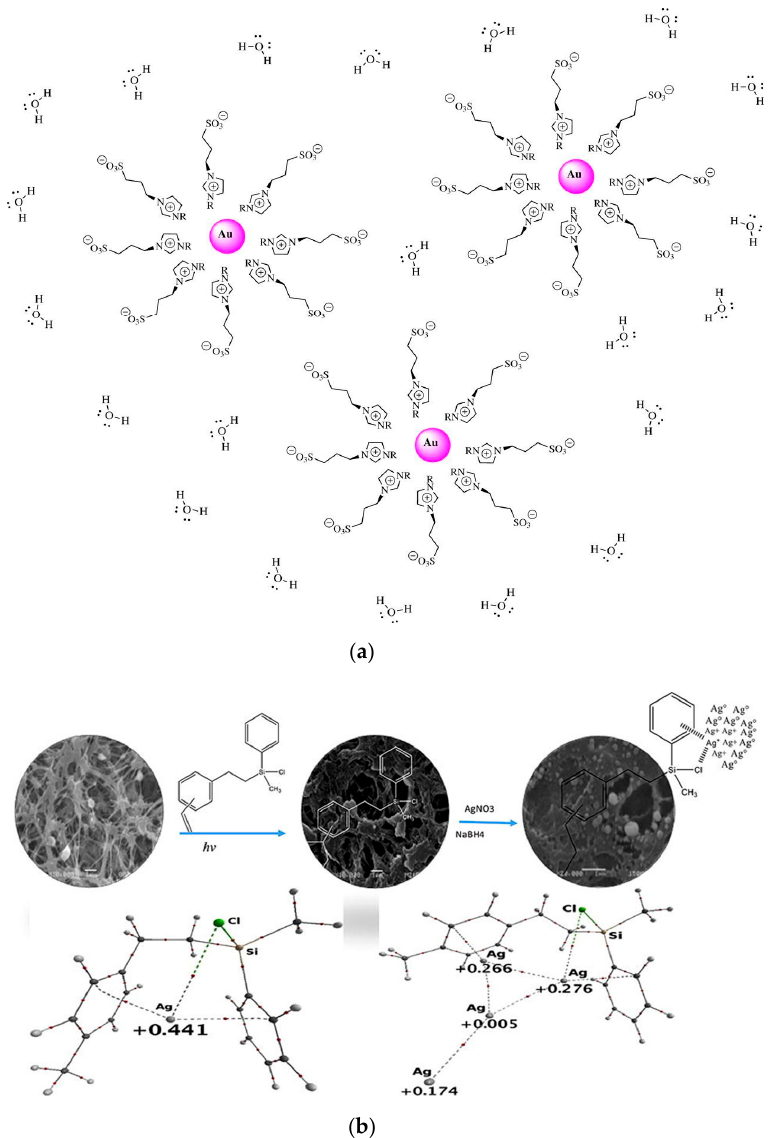
Figure 1. ( a ) Scheme of AuNPs stabilized with imidazolium salts in water. Reproduced with permission from [37]. Copyright Royal Society open science, 2017.; ( b ) Synthesis of PP-ECMPS and used as a template for the synthesis of AgNPs. Reproduced with permission from [40]. Copyright